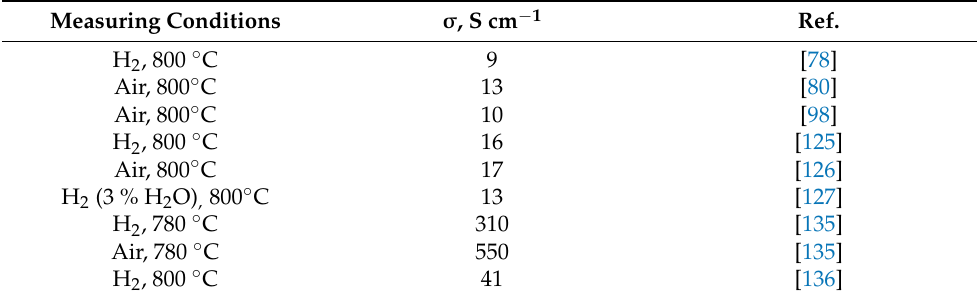
Table 7. Thermal expansion coefficients of Sr 2 Fe 1.5 Mo 0.5 O 6- δ in air. These data are also presented in Figure A1.